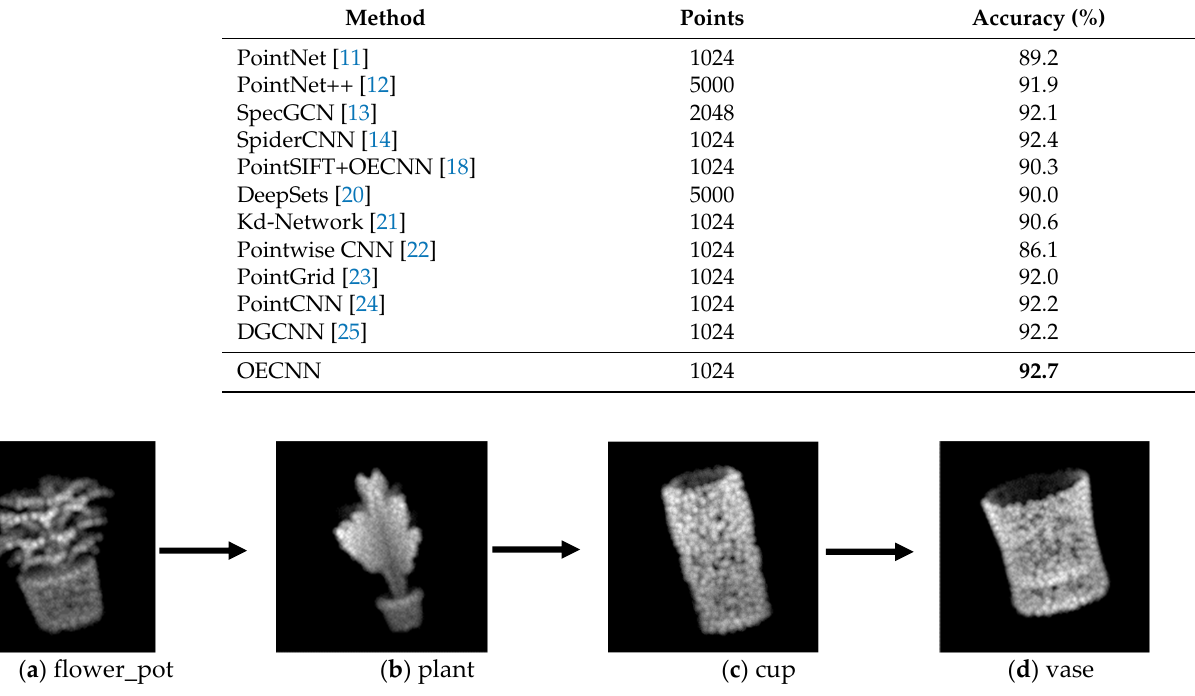
Figure 8. The visualization of misclassified samples on ModelNet40 [19]. Table 1. Classification accuracy of OECNN and other models on ModelNet40 [19].